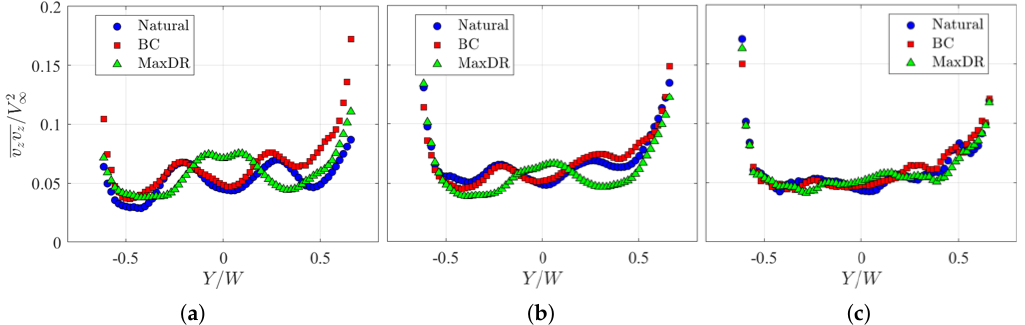
Figure 15. Vertical component of the mean squared velocity fluctuation v z v z in the natural, best compromise, and maximum drag reduction cases. We present the profiles at a fixed vertical location Z / W = 0.7 and at three streamwise locations: ( a ) X / W = 0.82; ( b ) X / W = 1; and ( c ) X / W =